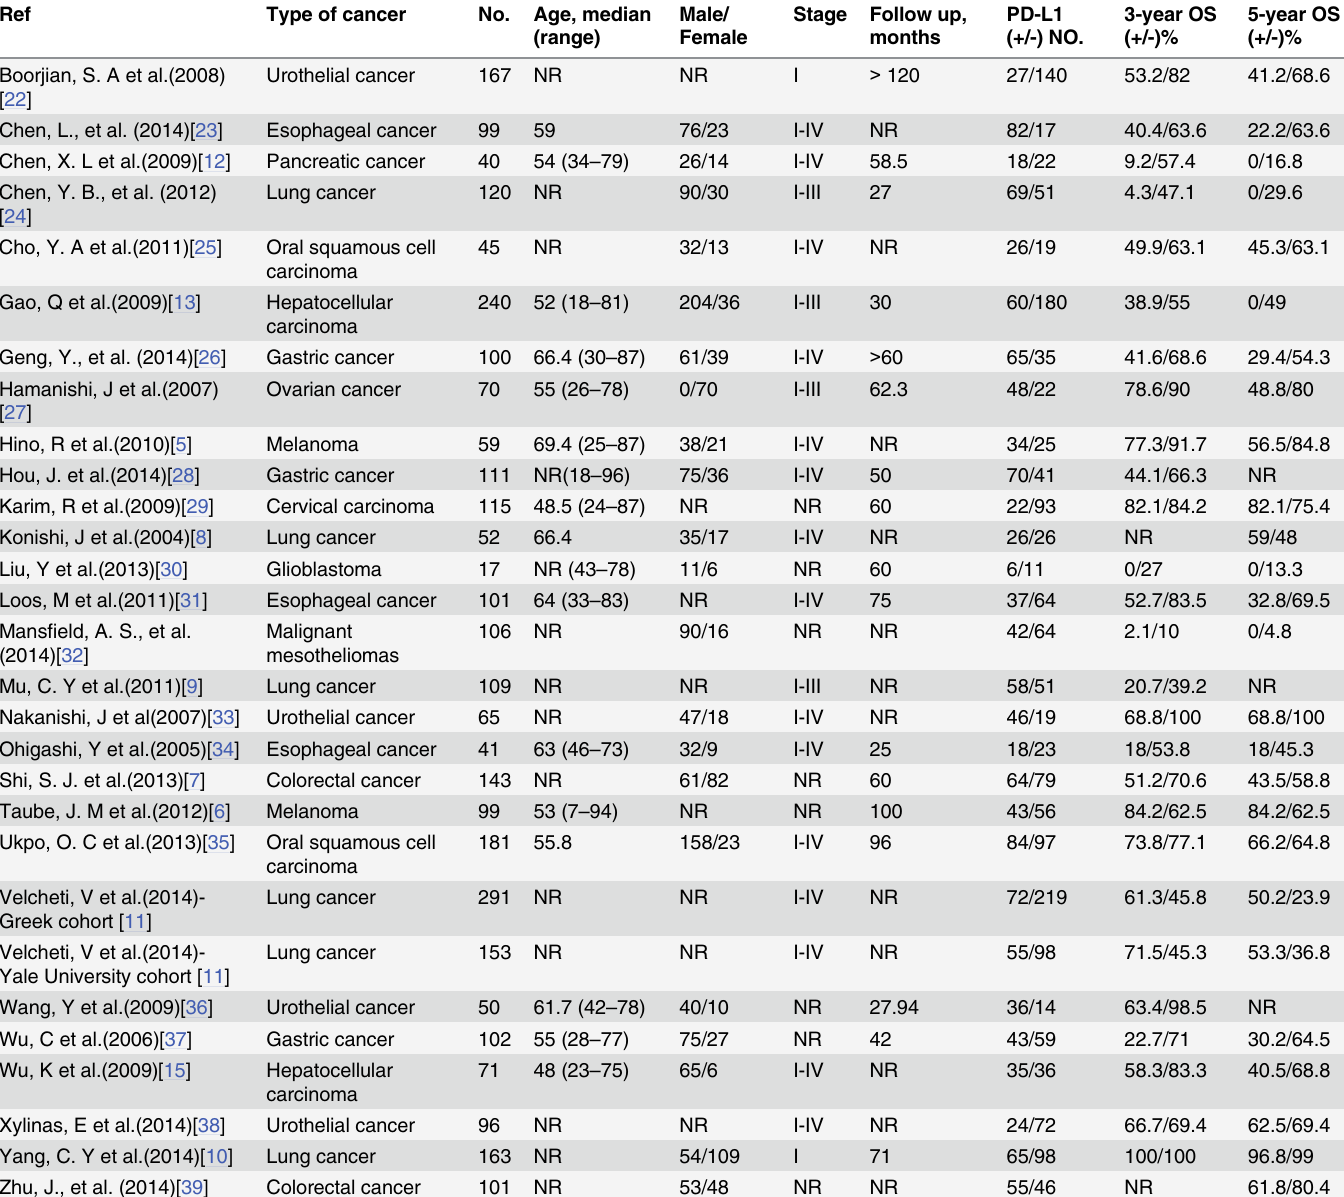
Table 1. Characteristics of studies included in the